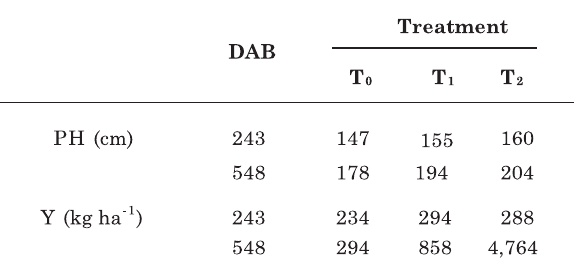
Figure 4. Shoot and root average dry matter (DM) distributions at the end of each agricultural year. to C are compartments of shoot and root, C 1 12 and DAB = days after beginning.